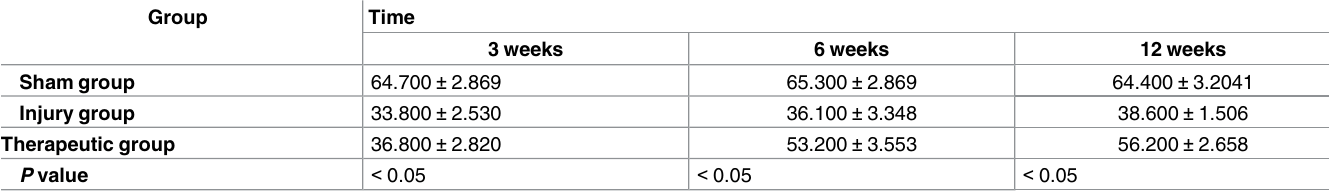
Table 2. Masson staining score for each group (x ± s, n =